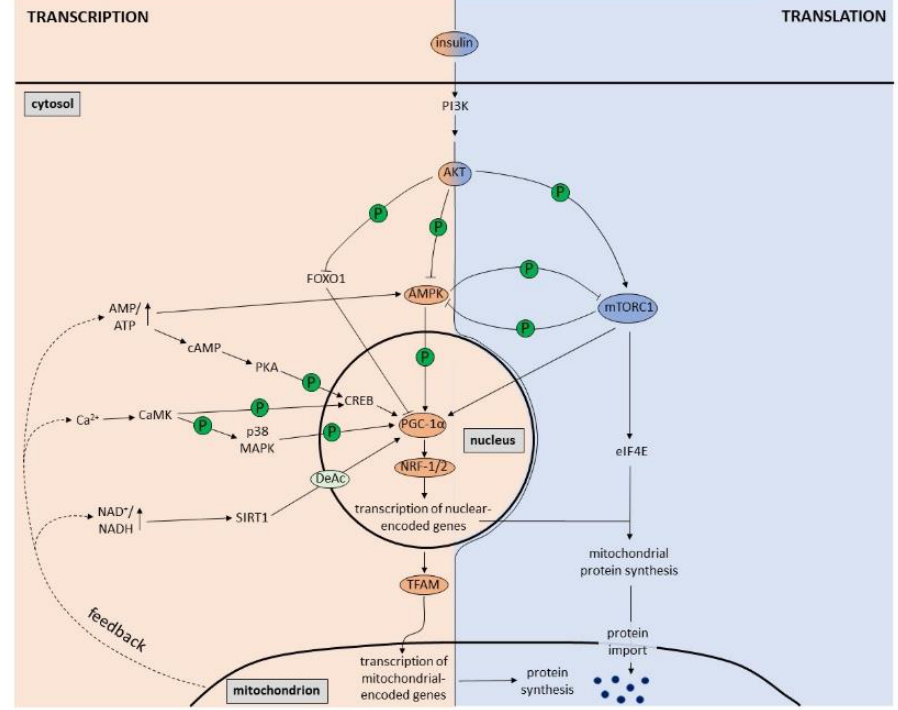
Figure 1. Regulation of mitochondrial biogenesis at the transcriptional and translational level. At the transcriptional level, the PGC-1 α -NRF-1/2-TFAM pathway is the master regulator of mitochondrial biogenesis. Increased AMP/ATP ratio, NAD + /NADH ratio and Ca 2+ levels, which are part of mitochondrial feedback mechanisms within the cell, result in activation of AMPK, PKA, SIRT1 and CaMK that in turn lead to PGC-1 α stimulation. Once activated, PGC-1 α promotes transcription of nuclear-encoded mitochondrial genes via NRF-1/2 and transcription of mitochondrial-encoded genes via expression of TFAM. At the translational level, the insulin-induced PI3K/AKT/mTORC1 pathway plays a major role in mitochondrial biogenesis. Via activation of eIF4E, mTORC1 increases the translation of nuclear-encoded mitochondrial proteins, which are imported into mitochondria.